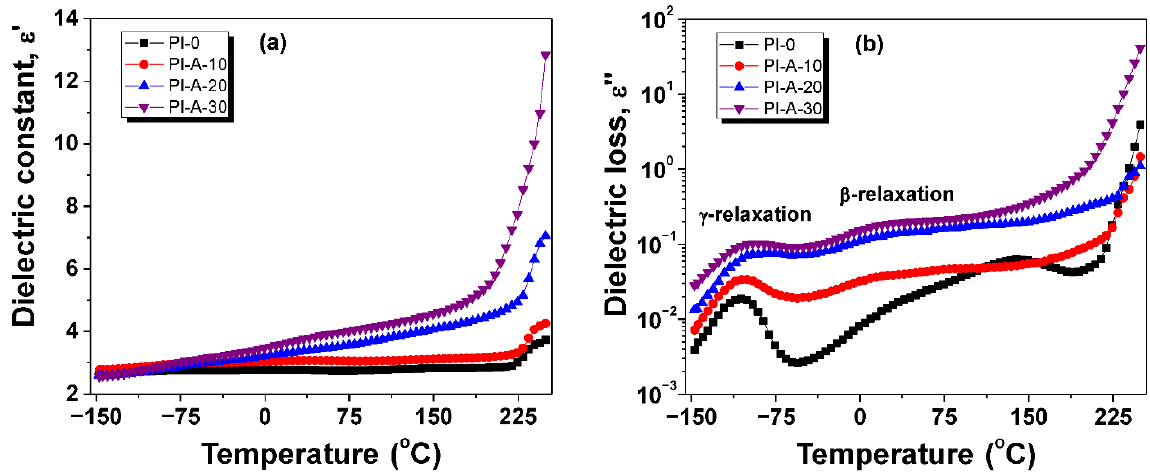
Figure 6. Dielectric constant ( a ) and dielectric loss ( b ) evolution with temperature for PI-0, PI-A-10, PI-A-20, and PI-A-30, at a frequency of 1 Hz.